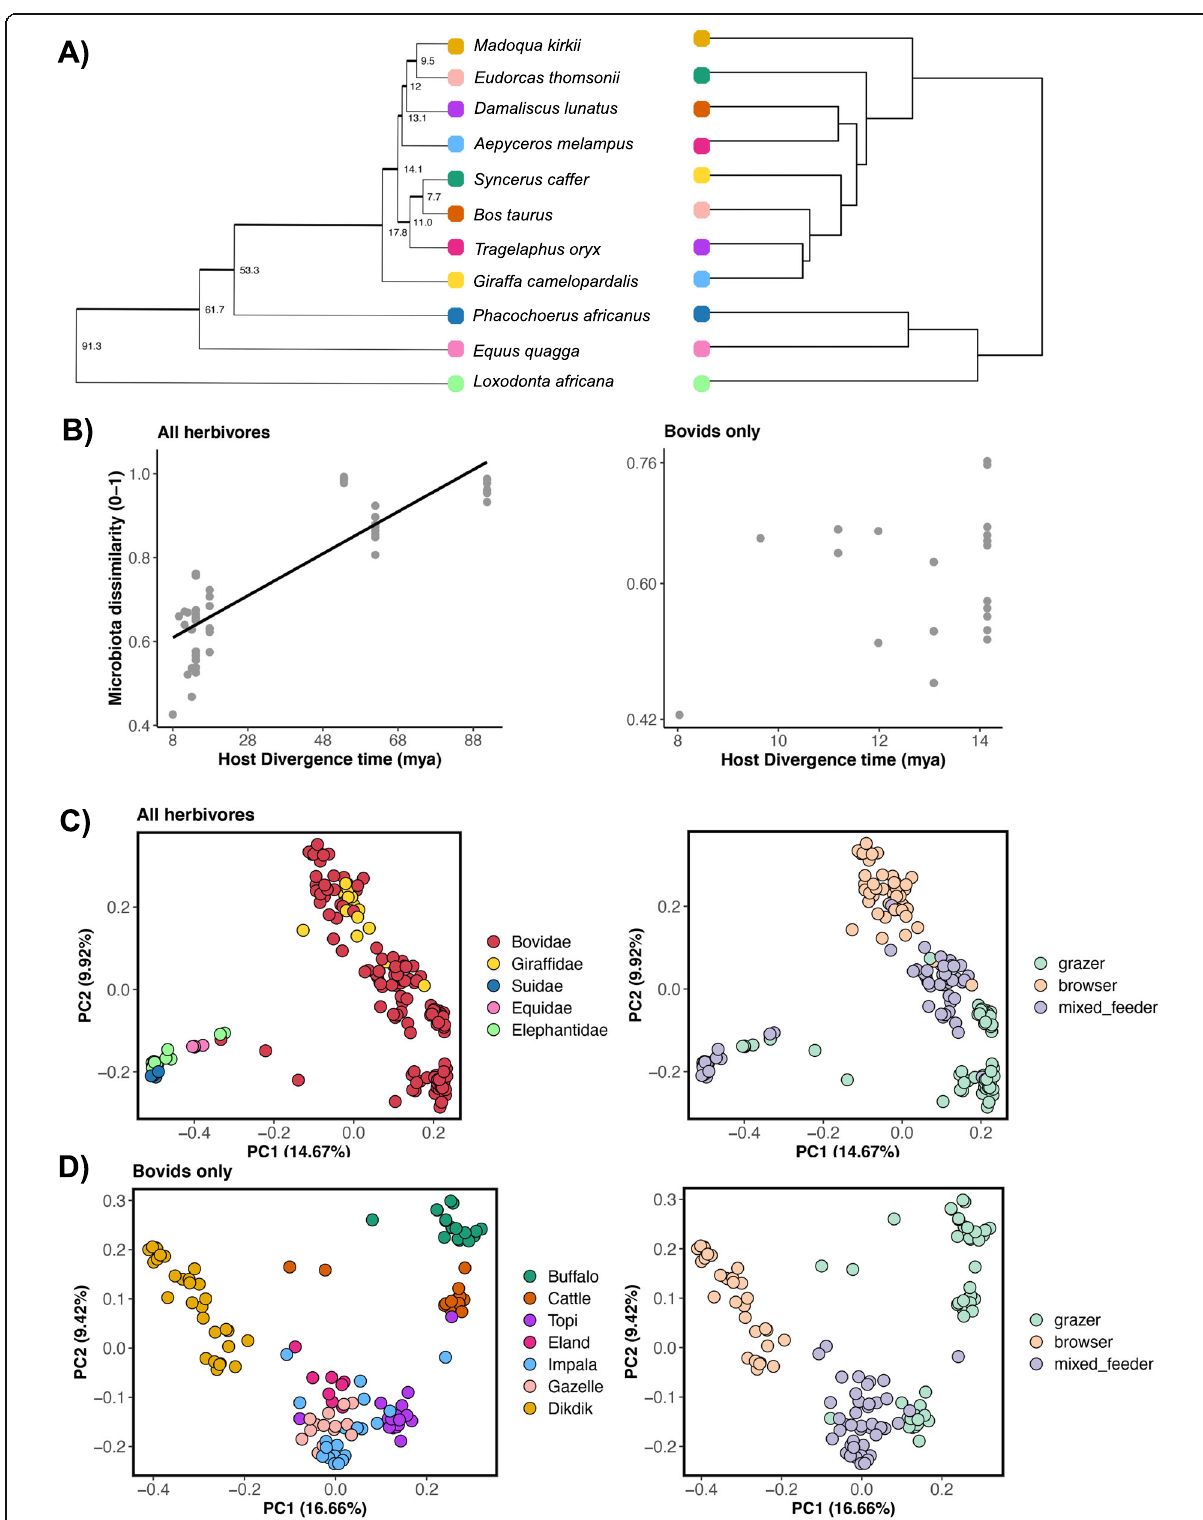
Fig. 1 (See legend on next